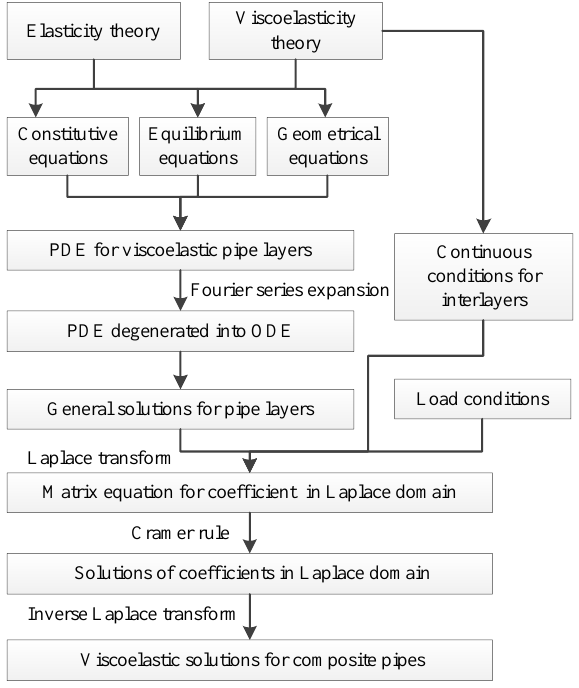
Figure 3. Flowchart of analytical process.